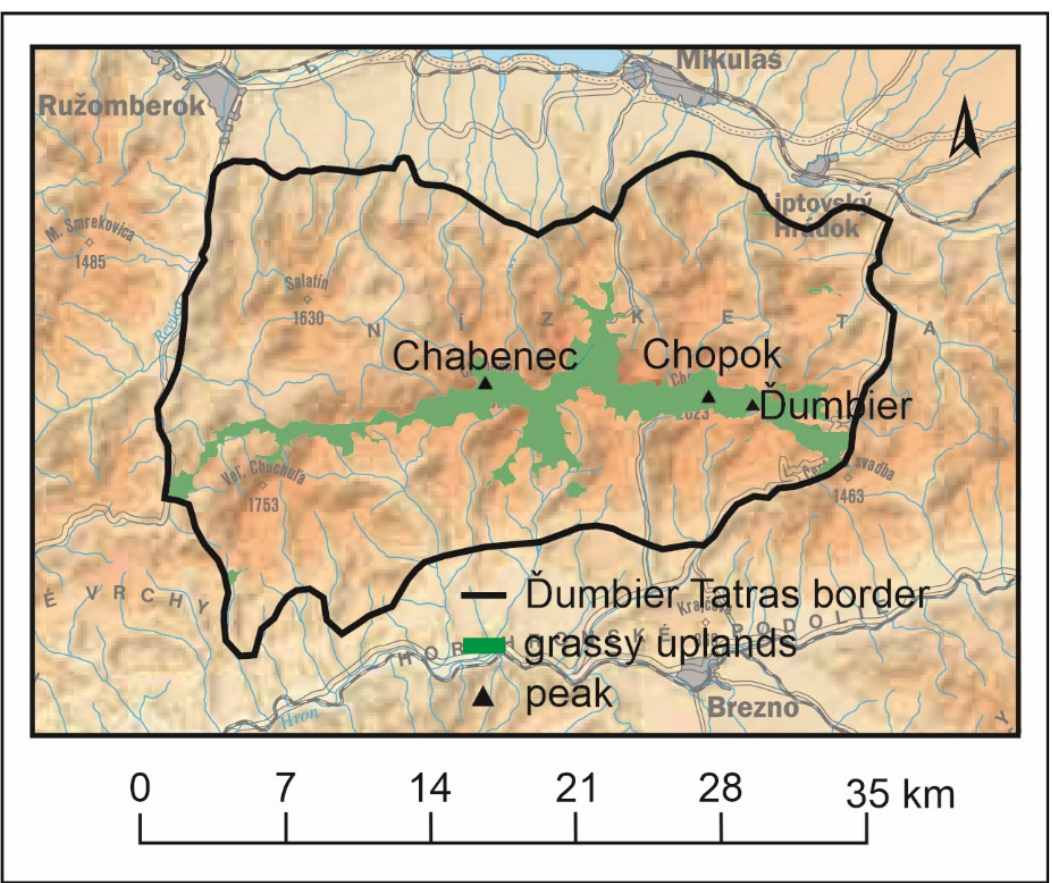
Figure 11. The current area of anthropogenically formed balds in the ˇDumbier Tatras mountain is 6665.61 ha, which showcases the potential habitat of the Alpine chamois. Source: CORINE Land Cover (Copernicus, 2018) and National Atlas of Slovak Republic, 2002.